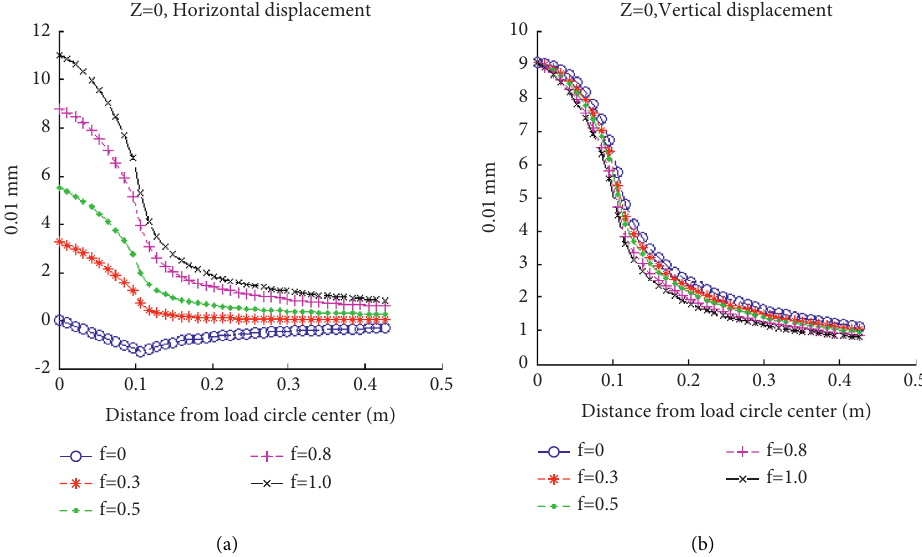
Figure 8: x -axis ( z � 0) displacement calculation results of structure. (a) Calculation results of horizontal displacement of structure in x -axis ( z � 0). (b) Calculation results of vertical displacement of structure in x -axis ( z �